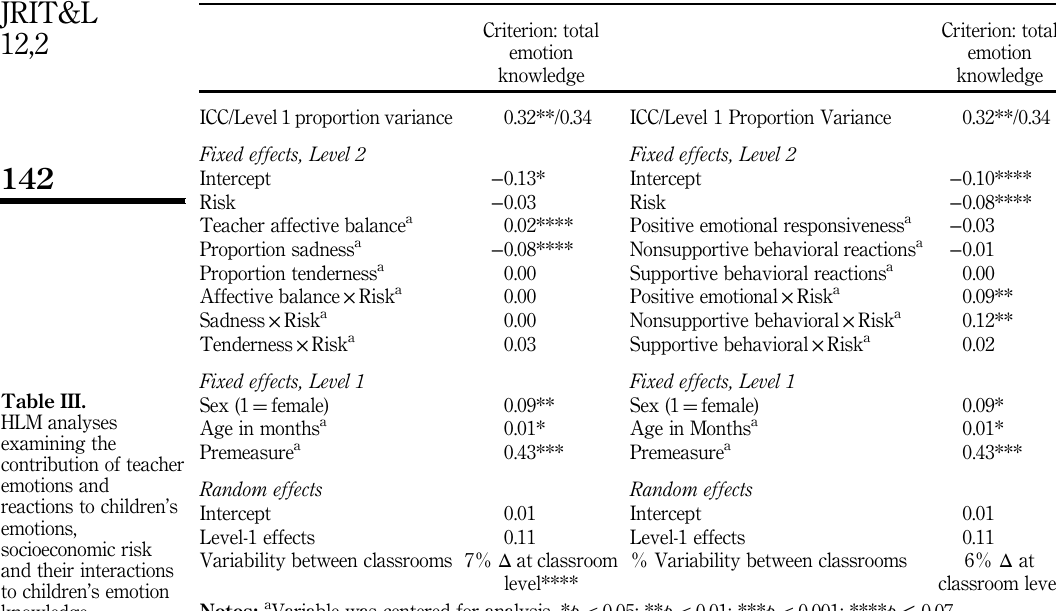
Table III. HLM analyses examining the contribution of teacher emotions and reactions to children ’ s emotions, socioeconomic risk and their interactions to children ’ s emotion